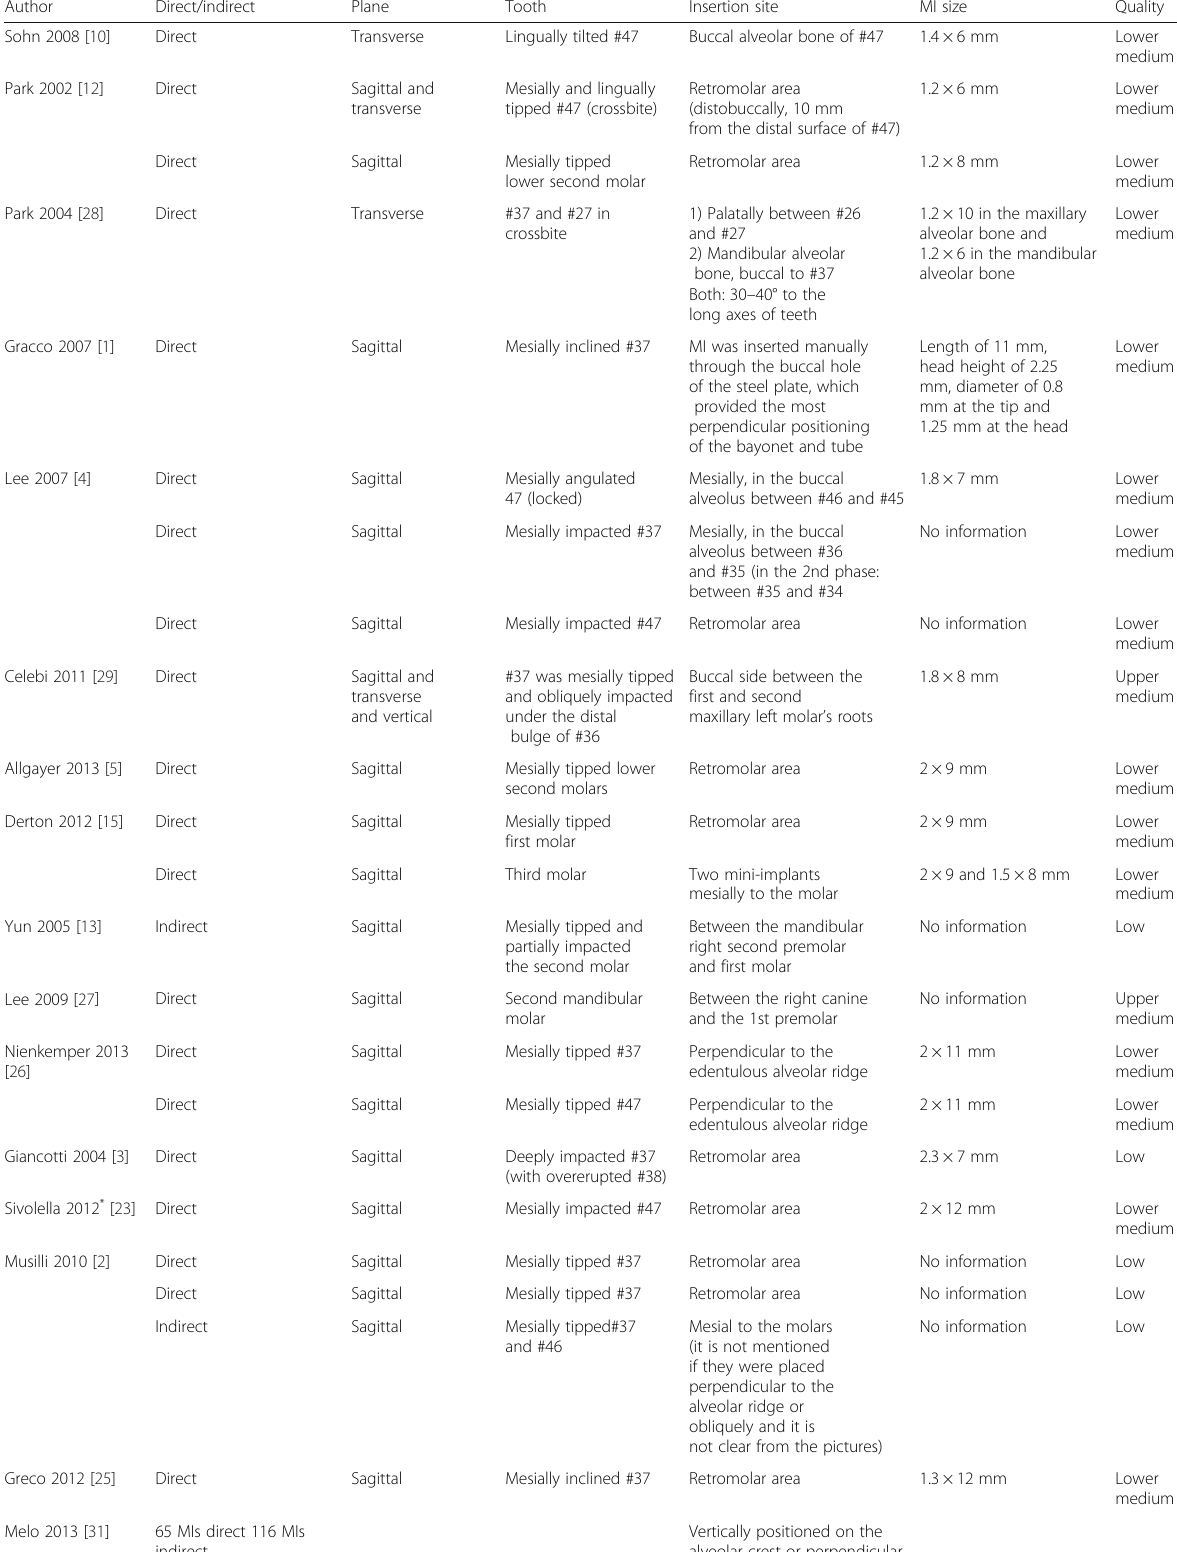
Table 1 Summary of cases included in this